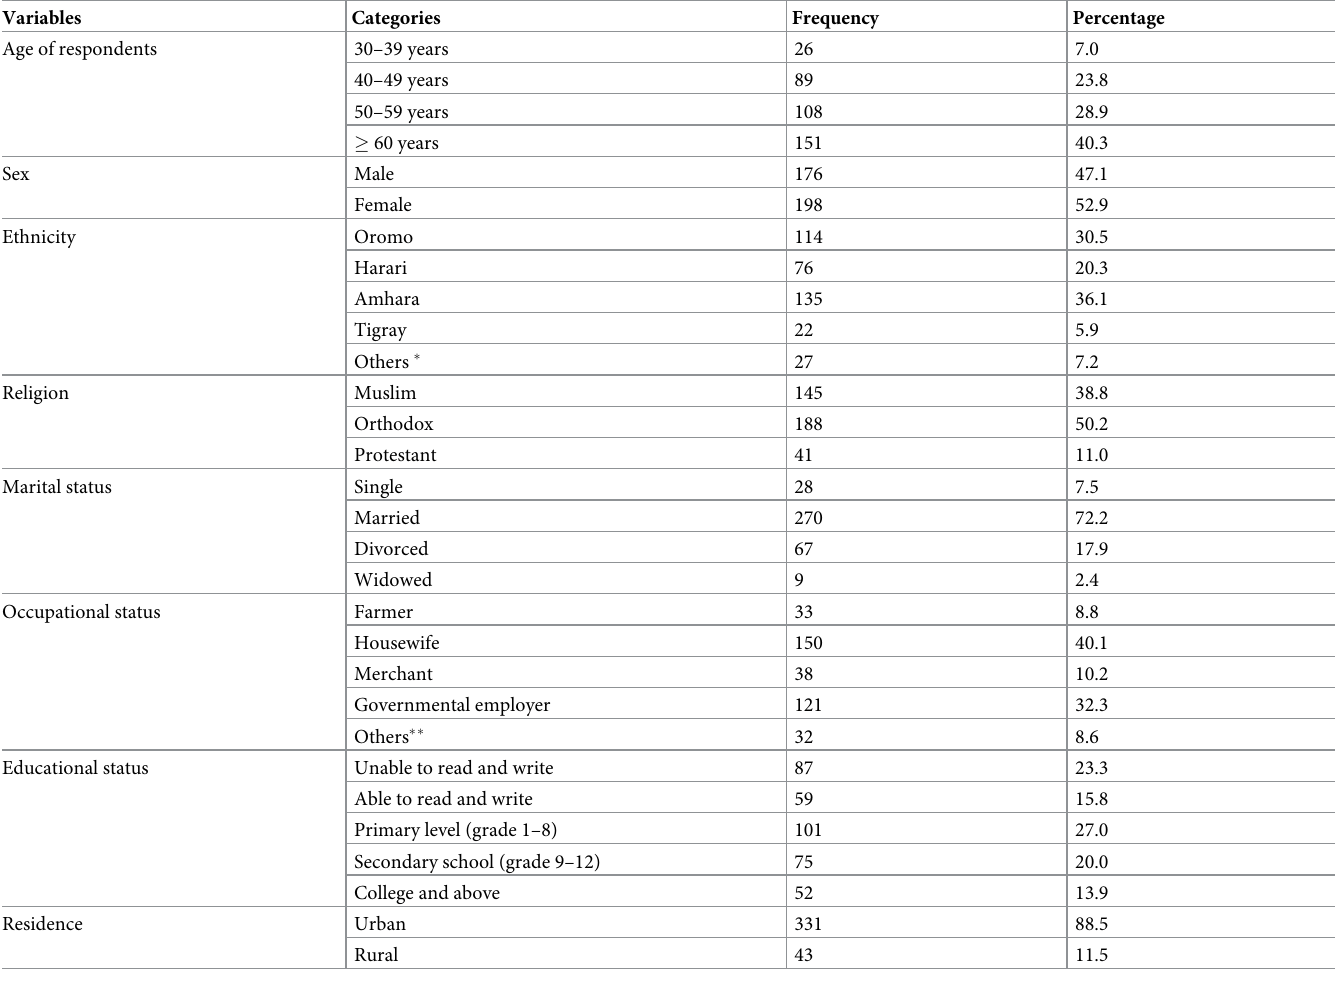
Table 1. Socio-demographic characteristicsofT2DM patients attending public hospitals in Harari region, Eastern Ethiopia, February to March 2019 (n =